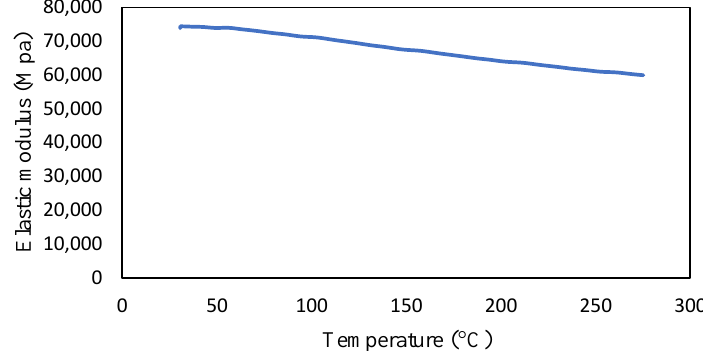
Figure 5. Elastic modulus of Al 2424-T3.